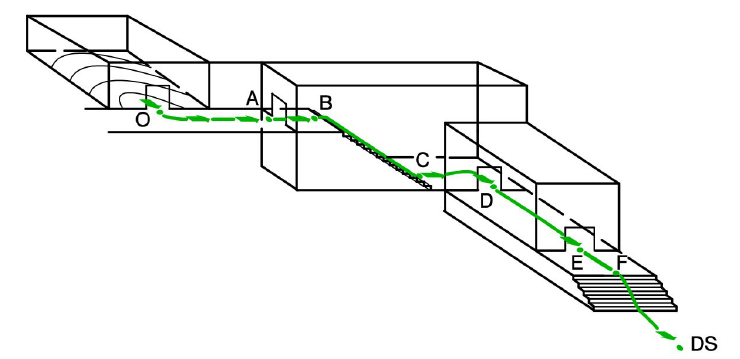
Figure 3. Architectural configuration of an evacuation